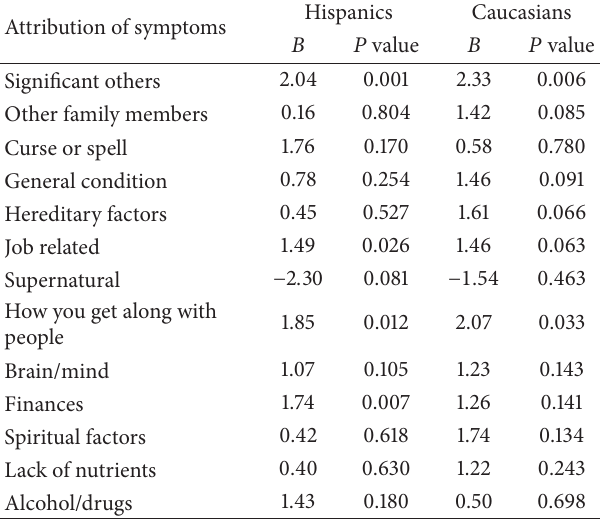
Table 4: Within-group linear regressions predicting CESD scores.